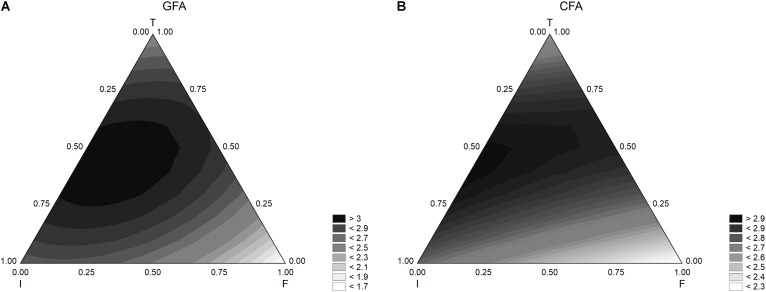
Triangular surfaces for the effect of flour (F), inoculum (I), and temperature (T) on the acidification (parameter ΔpHmax) performed by L. acidophilus. (A) GFA, design with gluten friendly flour; (B) CFA, design with control flour.